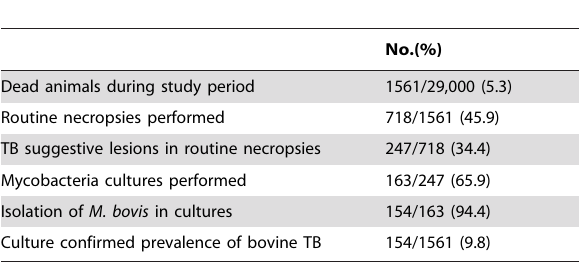
Table 2. Cattle infected with Mycobacterium bovis in dairy production and livestock facility in